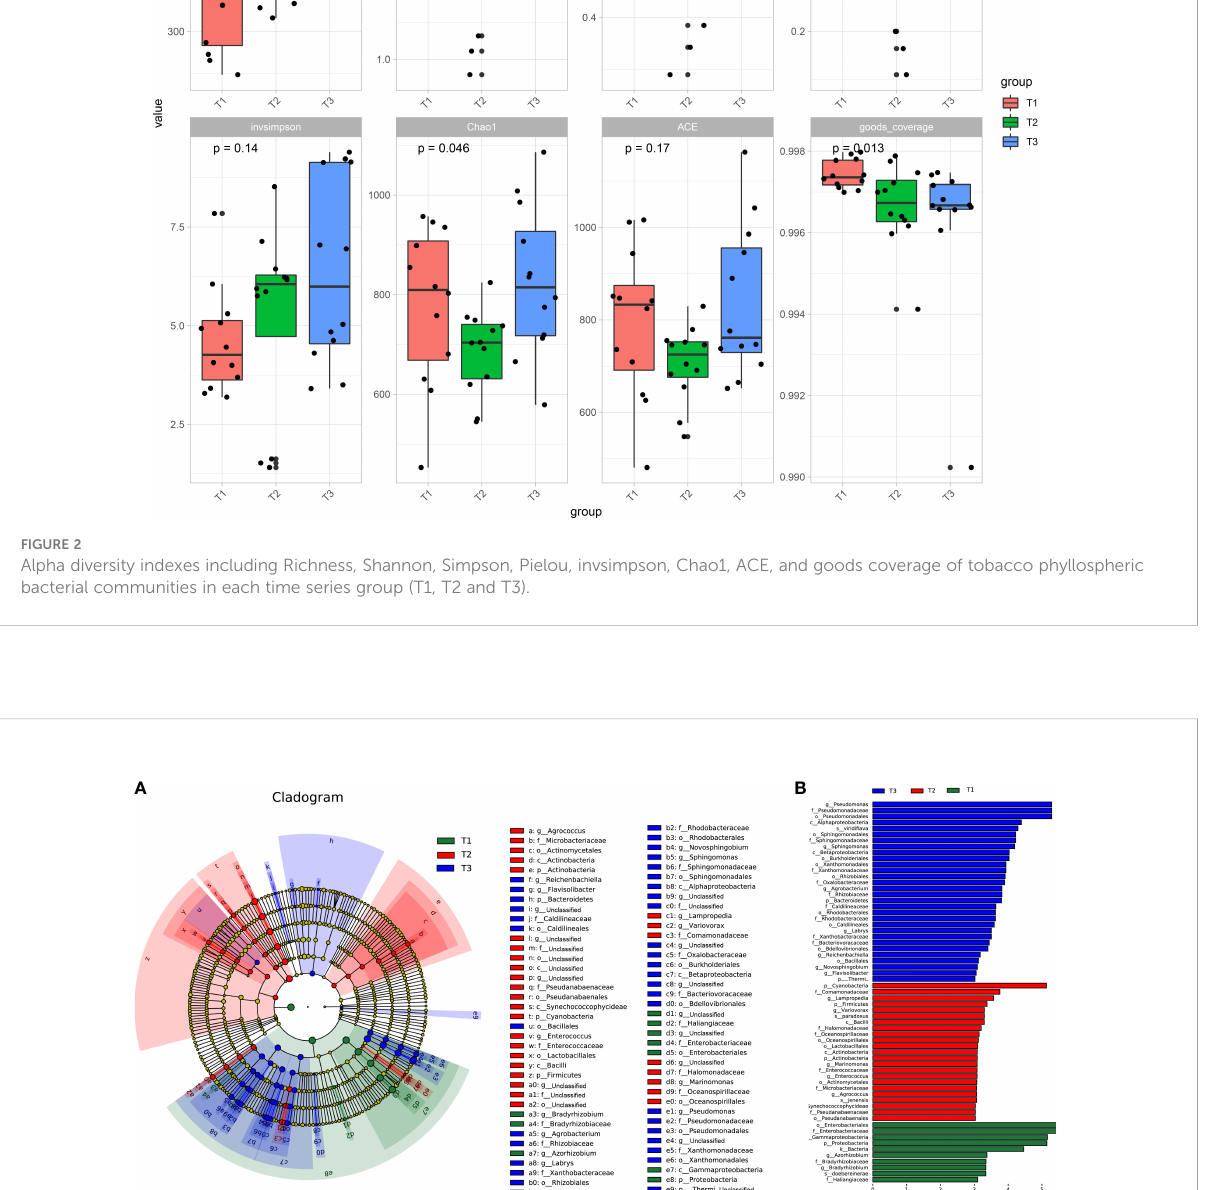
FIGURE 3 The linear discriminant analysis effect size (LEfSe) analysis at species level of bacterial communities (with LDA score >3.1 and p < 0.05) among T1, T2 and T3 groups presented by (A) cladogram (B) and distribution histogram.